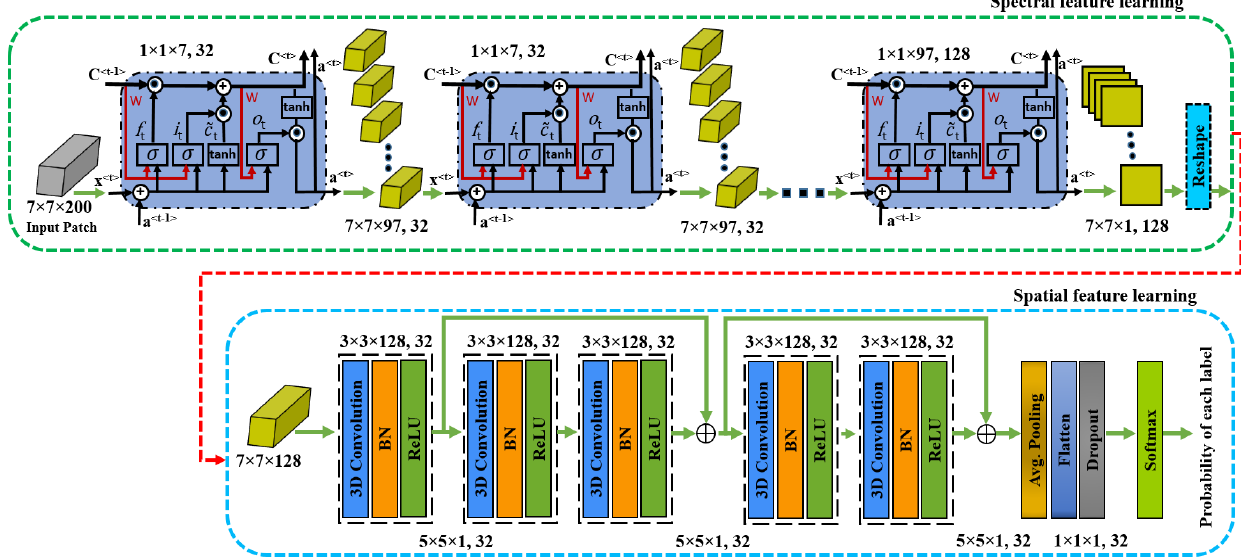
Figure 2. The proposed spectral–spatial 3D ConvLSTM-CNN-based Residual Network (SSCRN). An HSI image is decom- posed into a sequence of patches used as input to the ConvLSTM cell. The <t> represents the output/activation of the current cell/layer of the ConvLSTM , while <t − 1> represents the output/activation of the previous